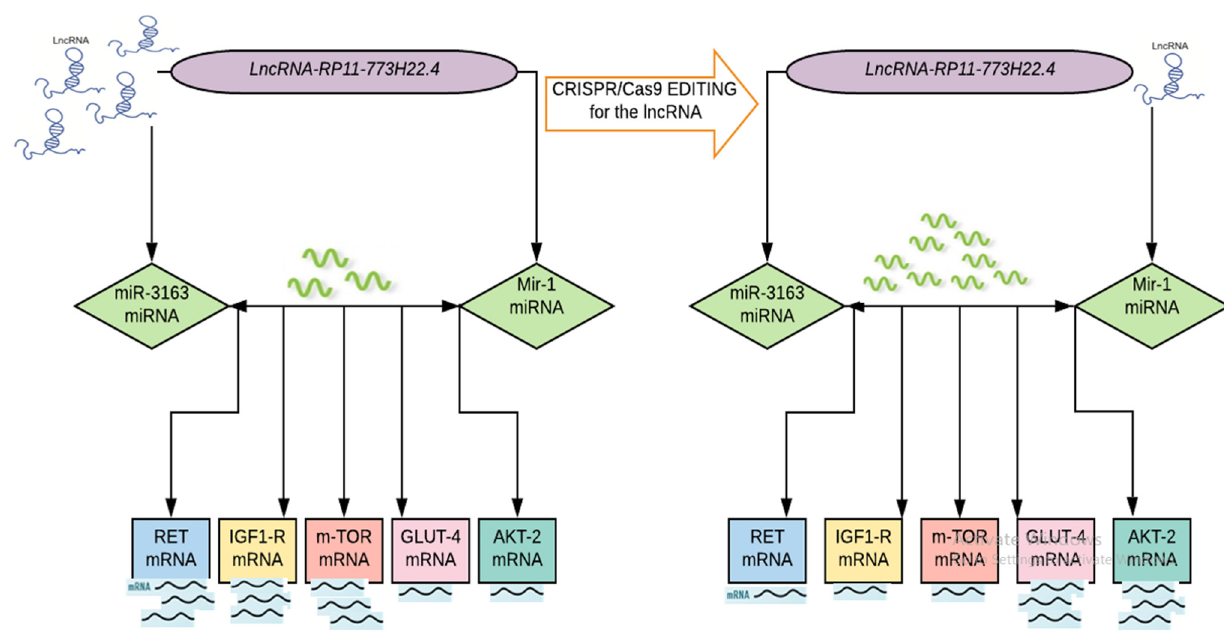
Figure 3. Proof of concept of ceRNA hypothesis in IR in T2DM.